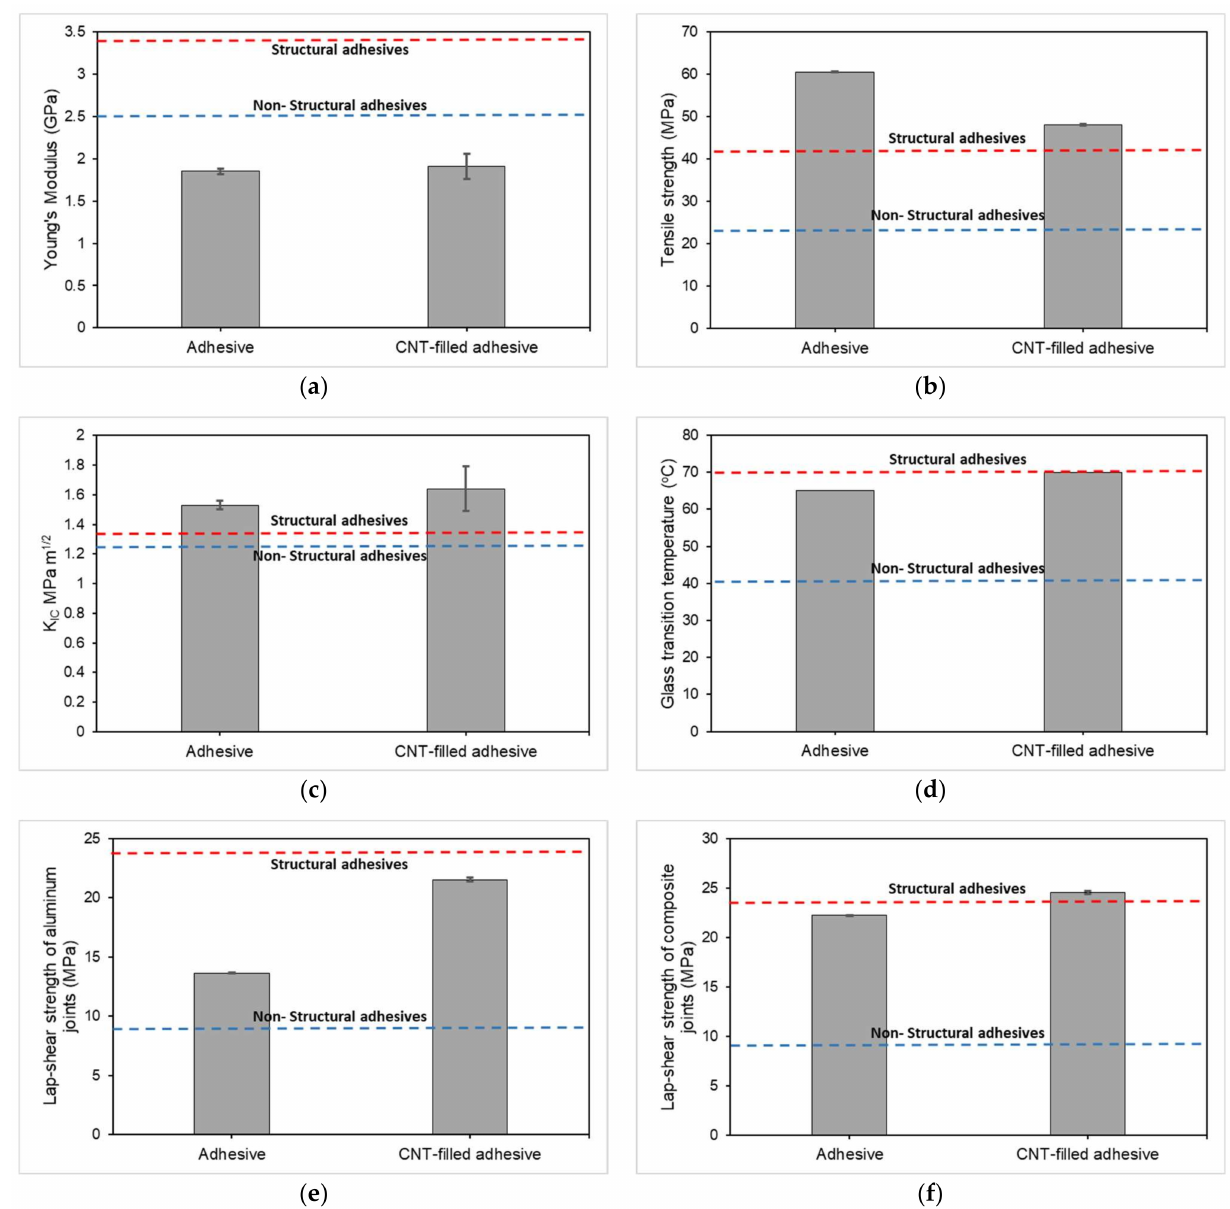
Figure 10. Comparison of mechanical properties of the neat and CNTs-filled bio-based adhesive with the average properties of structural and nonstructural (cosmetic) adhesives. ( a ) Young’s modulus: five specimens were tested, ( b ) tensile strength: five specimens were tested, ( c ) K IC : three specimens were tested, ( d ) glass transition temperature: one specimen was tested, ( e ) lap-shear strength of aluminum joints: five specimens were tested, ( f ) lap-shear strength of composite joints: specimens were